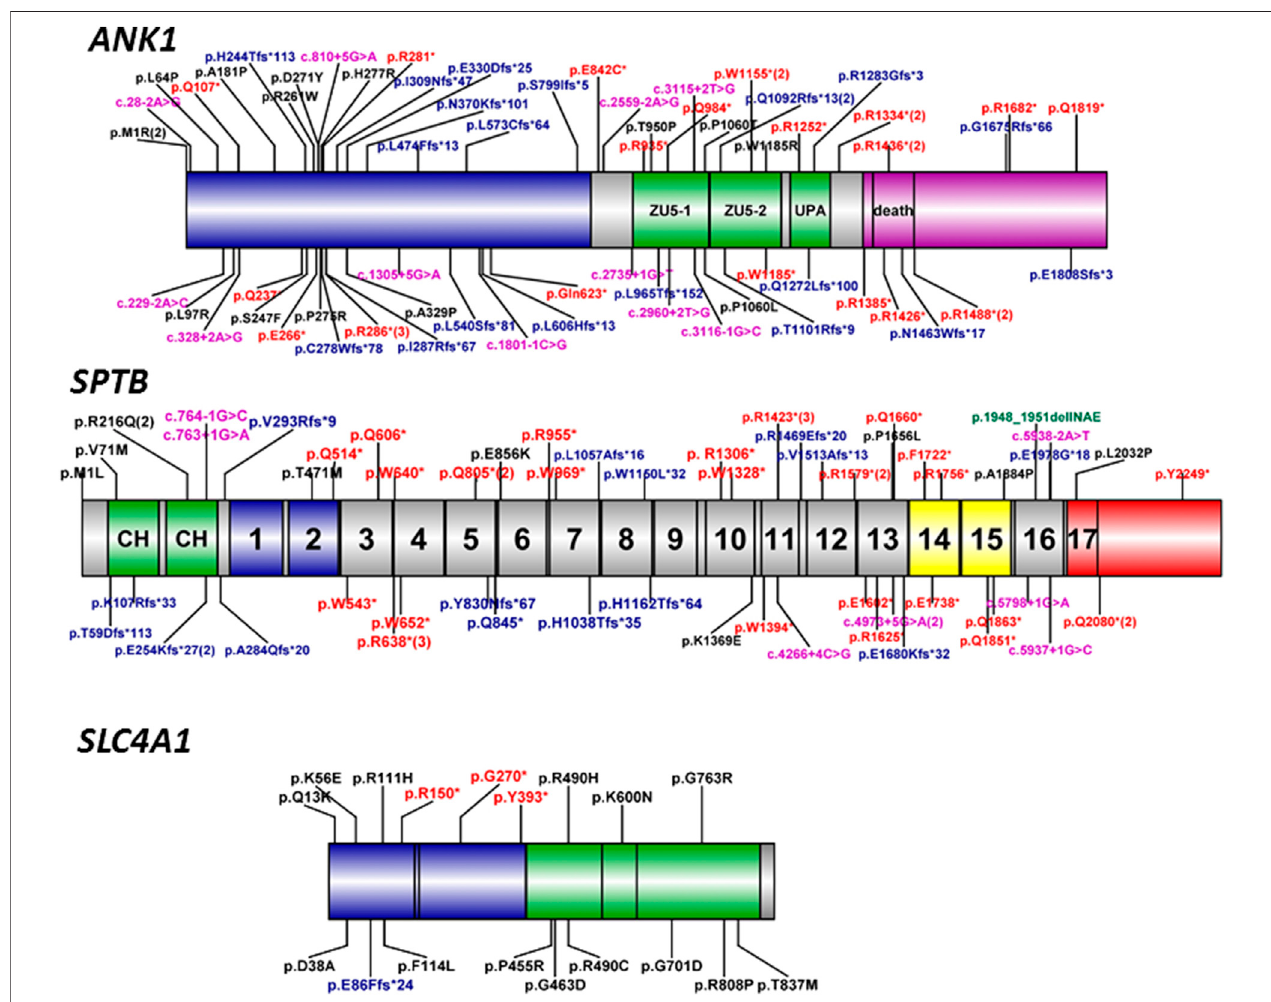
FIGURE 3 | Schematic diagram of ankyrin, ß -spectrin, and band three protein domains with ANK1, SPTB, and SLC4A1 mutations. Human erythroid ankyrin encodedby ANK1 consistsofanN-terminalmembraneproteinbindingdomaincontainingankyrinrepeats(bluebox),acentralspectrin-bindingdomainthatinvolvestwo ZU5 and the UPA domains (green box), and a C-terminal regulatory domain that modulates the af fi nities of the other domains and contains a death domain (violet box). Humanerythroid-spectrinproteinencodedby SPTB mainlyconsistsoftwoN-terminalactin-bindingdomains(greenbox)andseventeenspectrinrepeats,ofwhich repeatsoneand2(bluebox)mediate α / β dimerformation,repeats14and15(yellowbox)aretheankyrin-bindingdomain,andthelastrepeatisatetramerizationdomain (red box). Human band three protein encoded by SLC4A1 mainly consists of an N-terminal cytoplasmic domain (blue box) responsible for ANK1 binding and the C-terminaldomain (green box) spanningthelipidbilayerinvolved inaniontransport. Thedifferent mutationtypes were labeled withdifferentcolors, black-missense,red- nonsense, blue-frameshift,